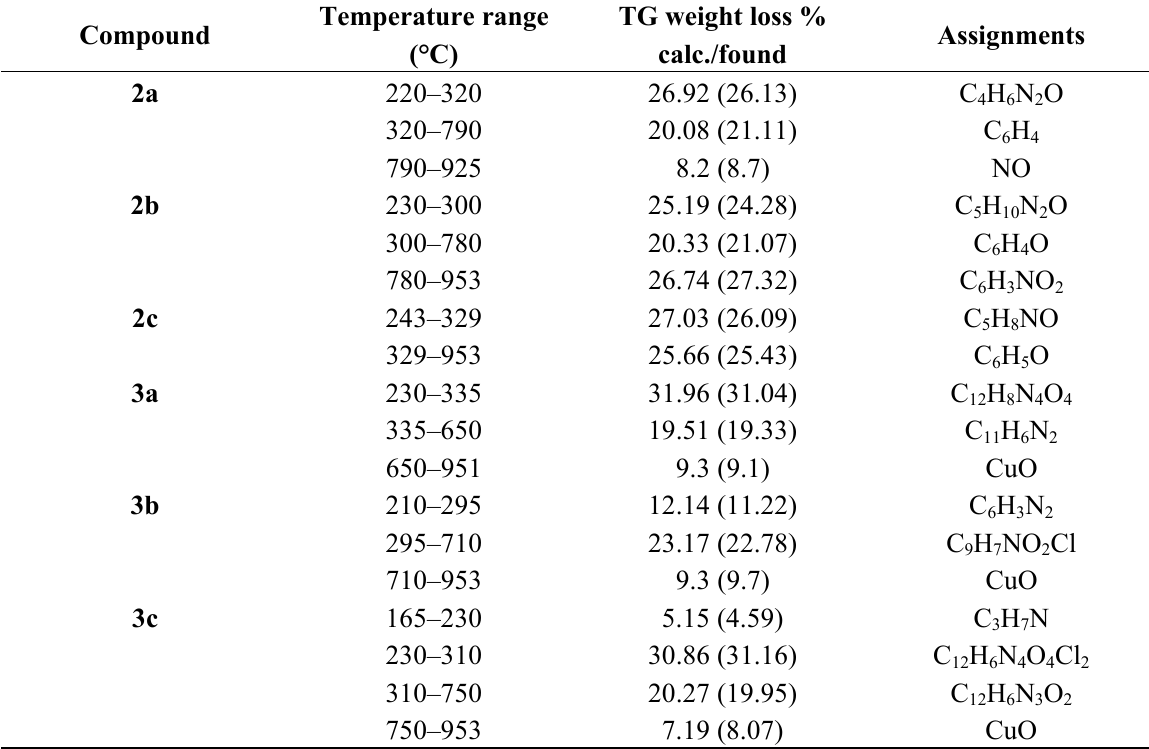
Table 2. Thermogravimetric analysis data for the ligands and copper(II)